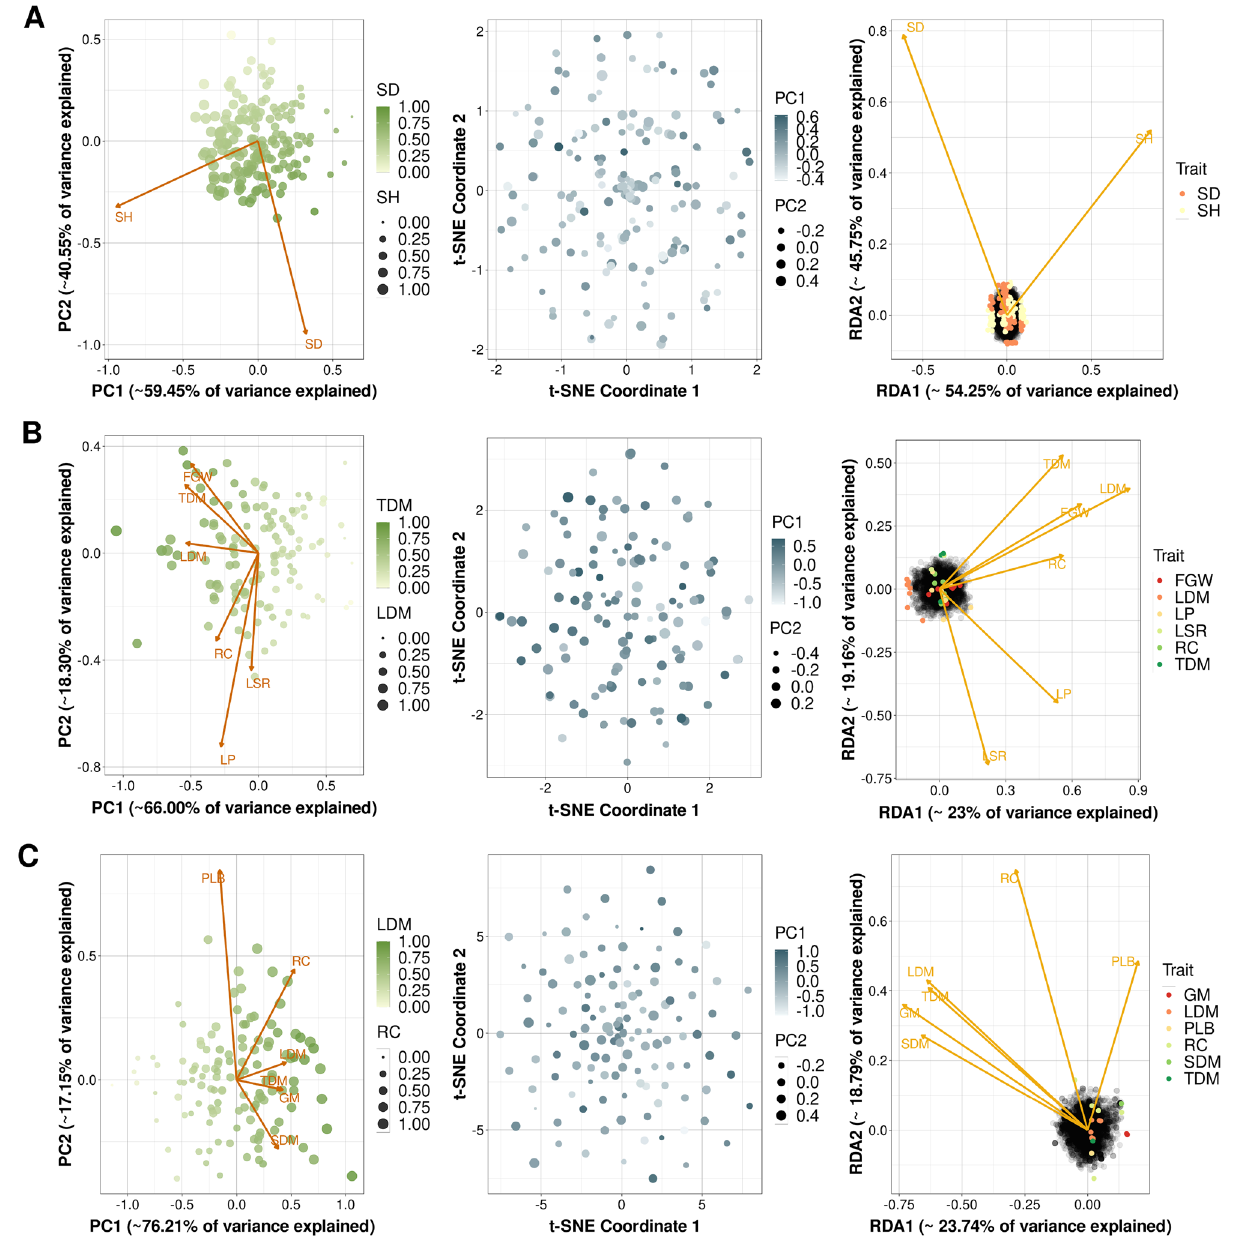
Figure 1. Multivariate analyses performed on both genotypic and phenotypic data for the populations of ( A ) sugarcane (stalk diameter (SD) and stalk height (SH)), (B ) Urochloa decumbens (field green weight (FGW), leaf dry matter (LDM), leaf percentage (LP), leaf stem ratio (LSR), regrowth capacity (RC), and total dry matter (TDM)), and ( C ) Megathyrsus maximus (green matter (GM), LDM, percentage of leaf blade (PLB), RC, stem dry matter (SDM), and TDM). Principal component analyses (PCAs) were performed with phenotypic data; t-distributed stochastic neighbor embedding (t-SNE), with genotypic data; and redundancy analyses (RDAs), with both